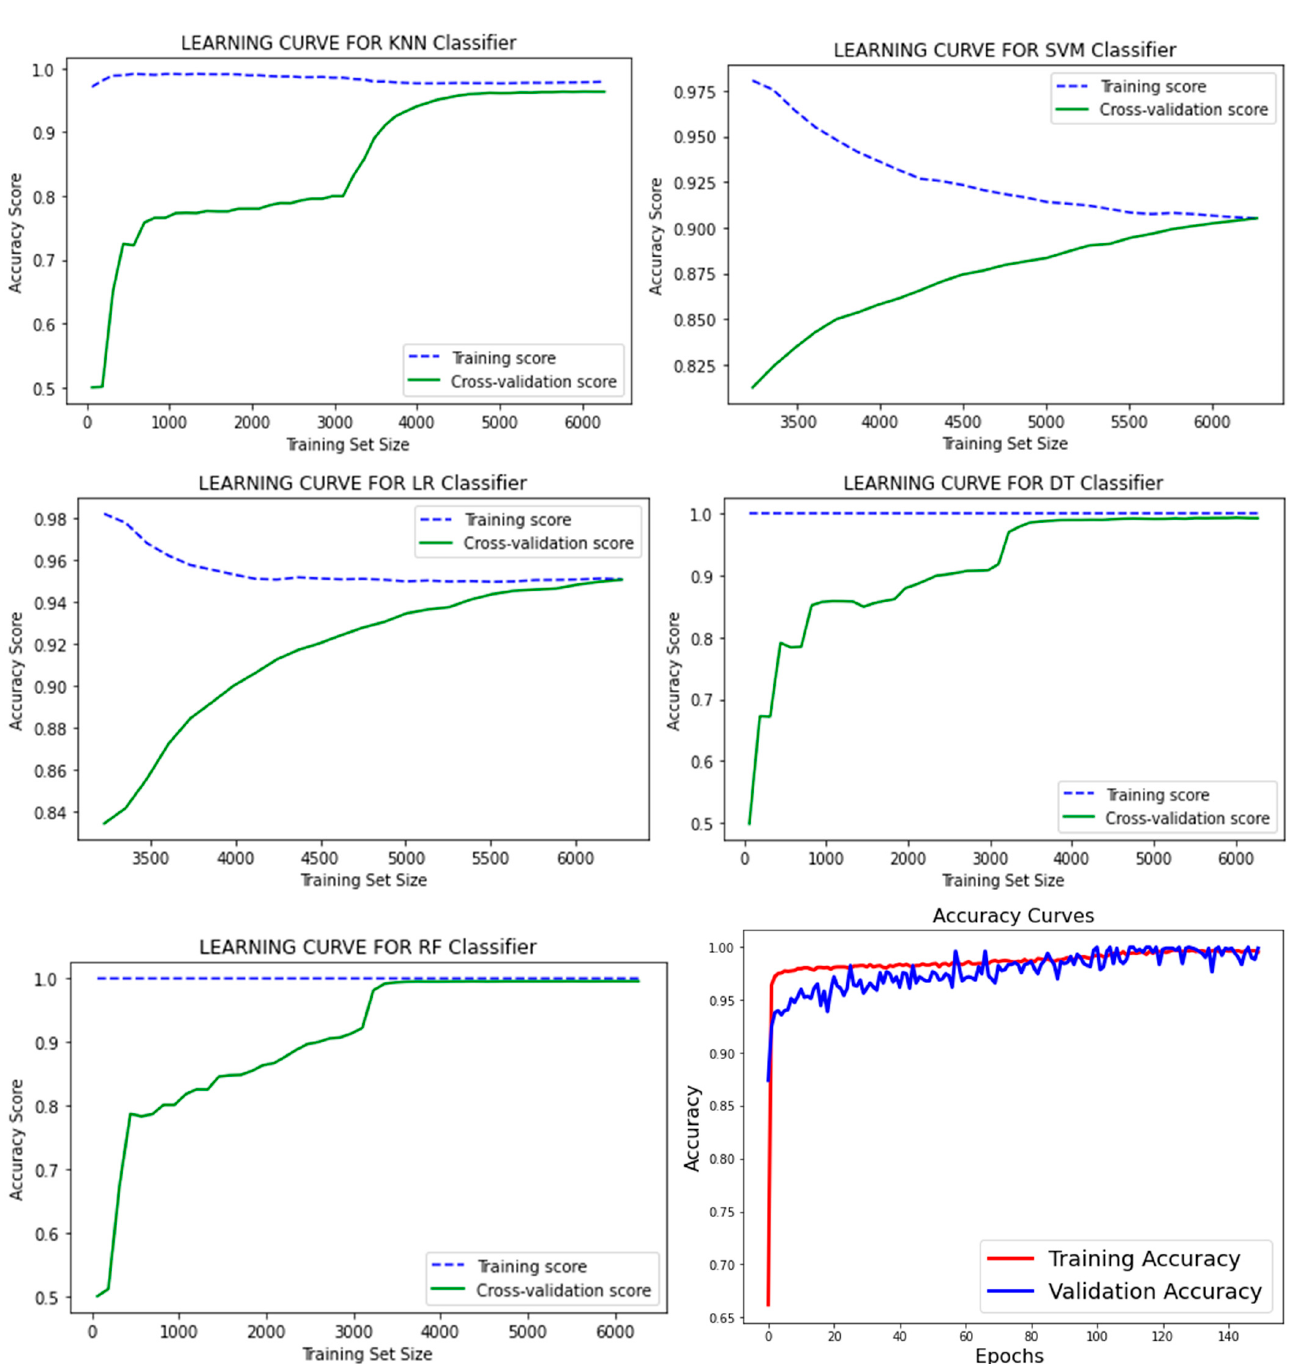
Figure 8. Learning curve of accuracy achievement of all ML models and the DL one.